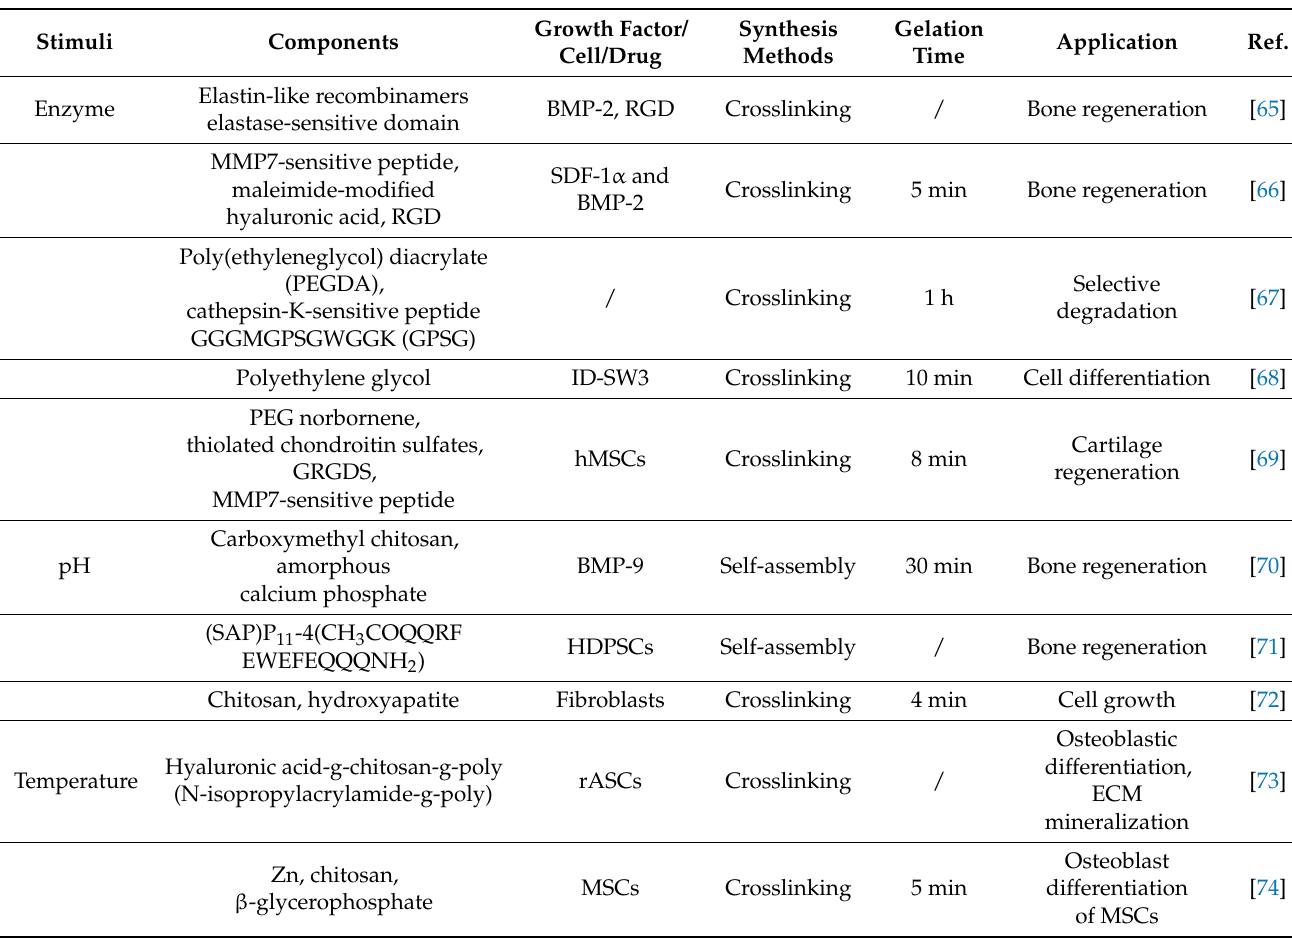
Figure 1. Stimuli-responsive hydrogels and their biological application. Table 1. Stimuli-responsive hydrogels in bone and cartilage tissue engineering.